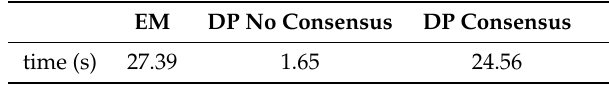
Table 8. Total run times (60 samples) of the network of 60